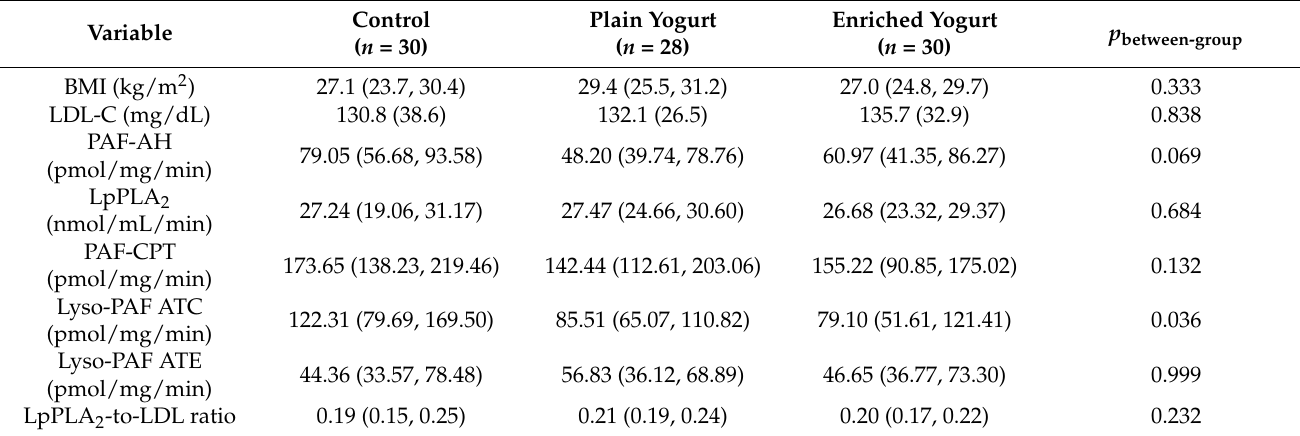
Table 2. Characteristics of the participants during the 4th week of the dietary intervention (ITT